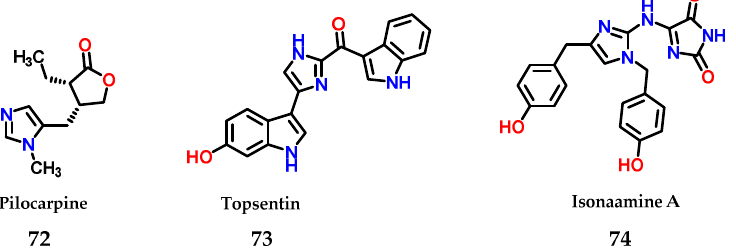
Figure 31. Structures of imidazole-containing natural products pilocarpine 72 , topsentin 73 and isonaamine A 74 .